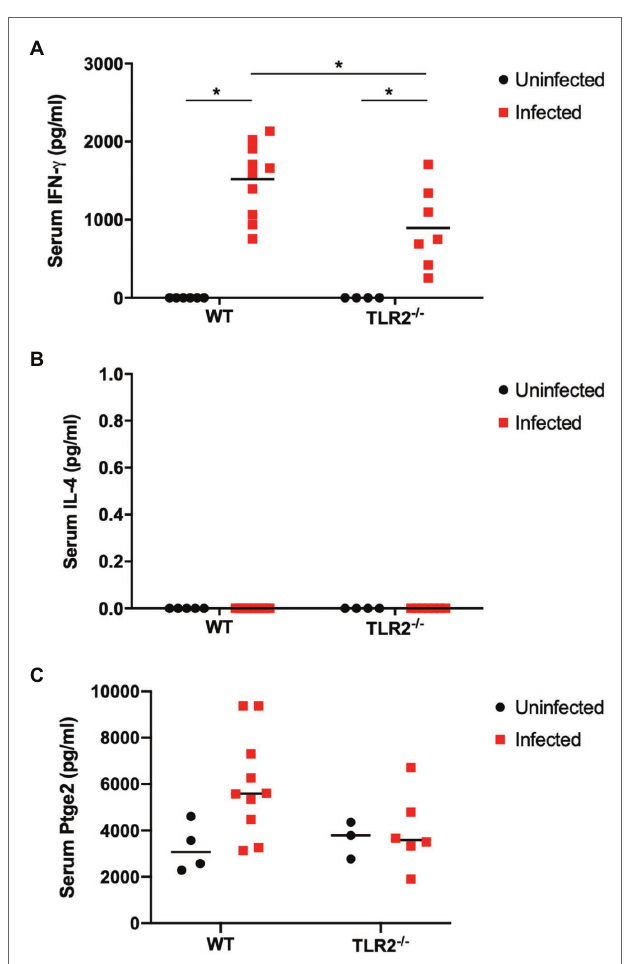
FIGURE 7 | Serum levels of IFN- γ (A) , IL4 (B) and prostaglandin E2 (C) on day 18.5 of pregnancy. Serum levels of IFN- γ , IL4 and prostaglandin E2 in each group were measured. Each point on the graph represents a single mouse, and the horizontal lines indicate the mean values for each group. Uninfected WT mice ( n = 6), infected WT mice ( n = 10), uninfected TLR2 − / − mice ( n = 4), infected TLR2 − / − mice ( n = 7). Data were analyzed with two-way ANOVA followed by the Tukey–Kramer multiple-comparison test. * p <